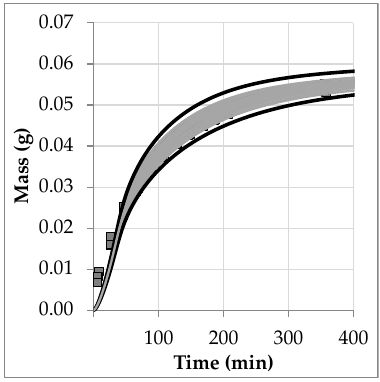
Figure 8. Sensitivity analysis, DoE.